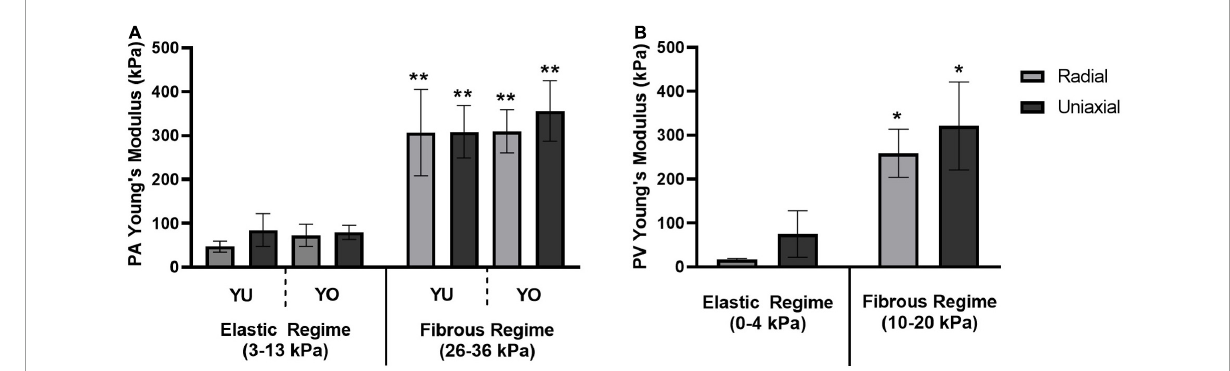
FIGURE4 Young’s Modulus for elastic and fibrous regimes. A comparison of Young’s Modulus values determined by the radial and uniaxial testing methods for (A) the pulmonary artery of both Yucatan and Yorkshire piglets, and (B) the pulmonary valve annulus region of Yucatan piglets. There was no significant difference in Young’s Modulus measurements between testing methods or breeds within a given regime. The Young’s Modulus of the fibrous regime was significantly higher compared to its corresponding elastic regime (* indicates p < 0.0005; ** indicates p < 0.0001).